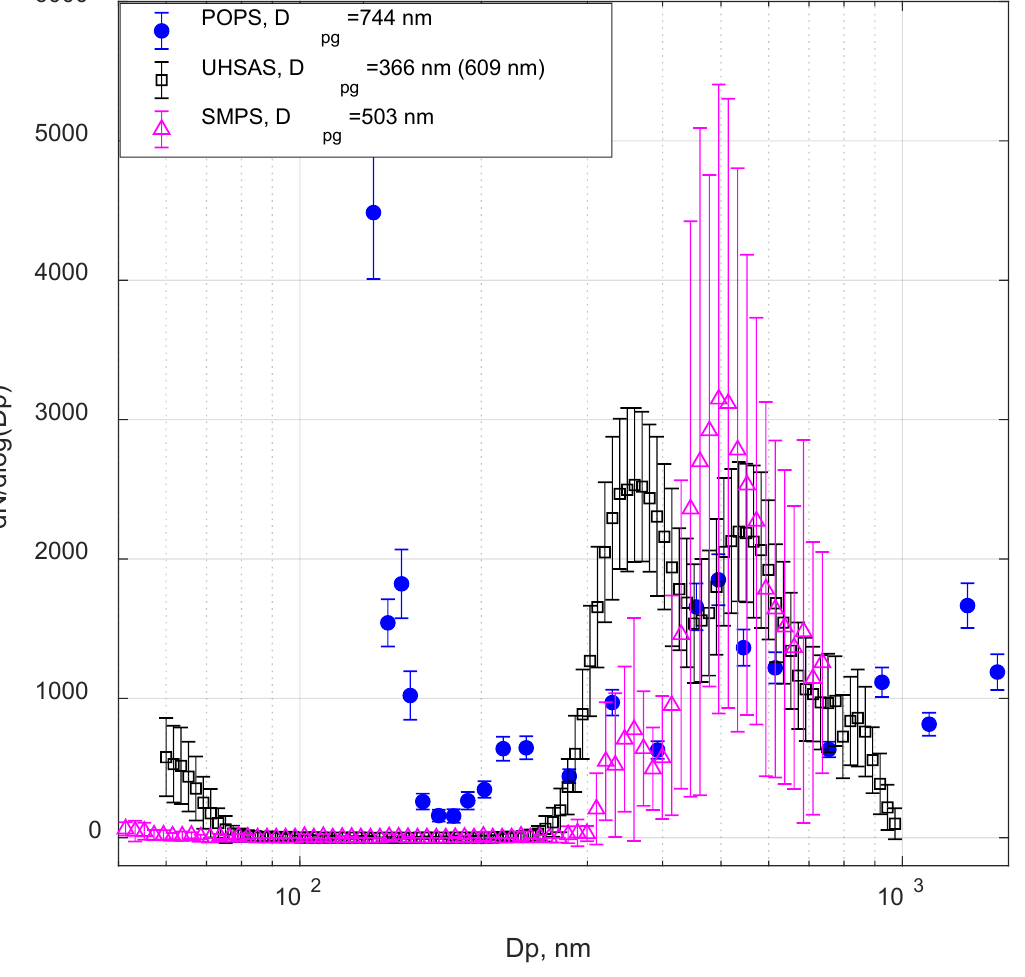
Figure 6. POPS and UHSAS size distribution of 500 nm (electrical mobility size) Arizona test dust (ATD) particles.